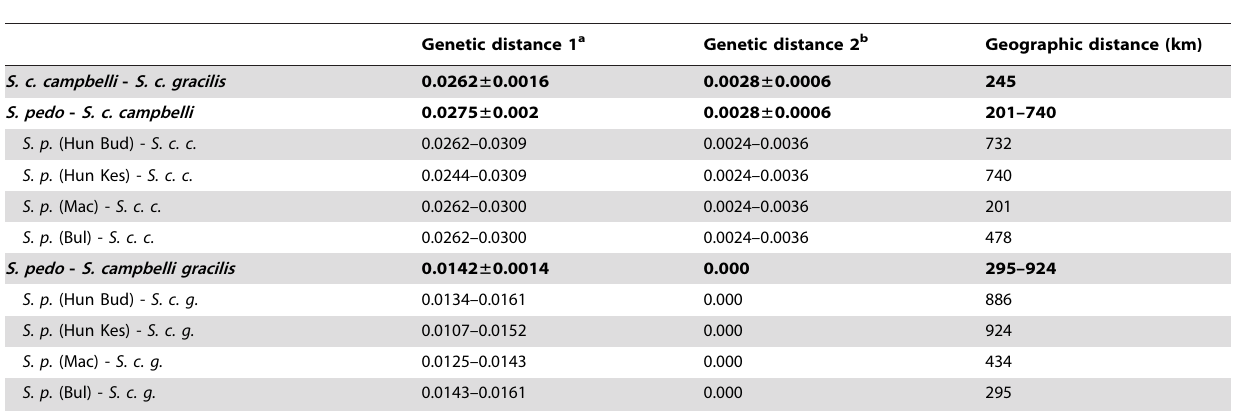
Table 2. Comparison of the genetic and geographic distances among Saga pedo , S. c. campbelli and S. c. gracilis .